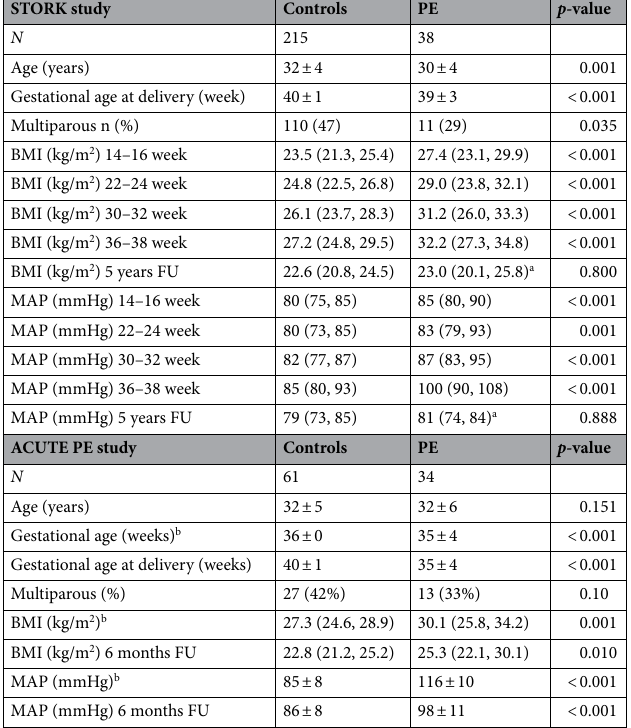
Table 1. Maternal characteristics in controls and preeclamptic (PE) pregnancies. Data given as mean ± SD when normal distributed and median (25th, 75th) when skewed distributed. BMI body mass index, MAP mean arterial pressure, FU follow-up. a N = 10 PE. b At blood